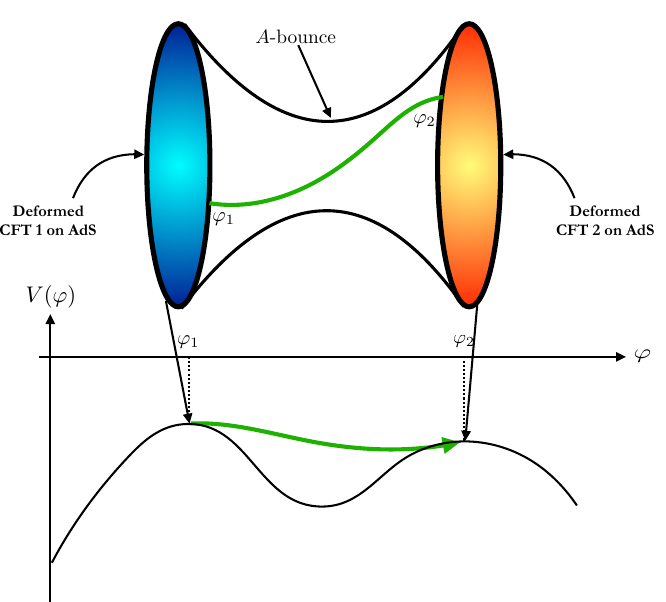
Figure 3 . Wormhole connecting two UV CFTs on AdS d living at different maxima of V ( ϕ ) . The solution has one A -bounce and no ϕ